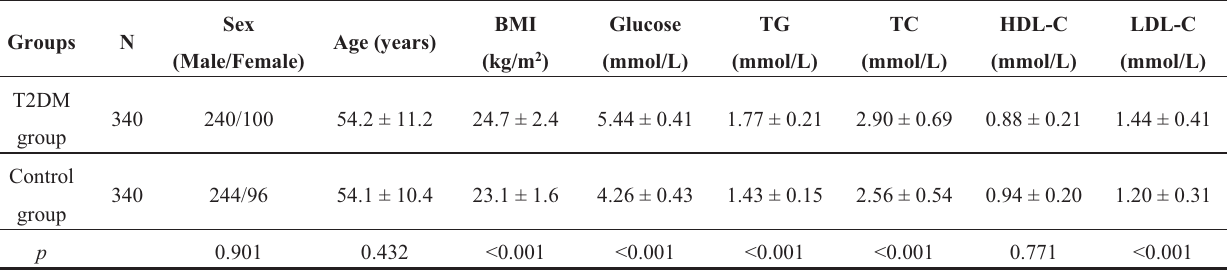
Table 1. Characteristics of the